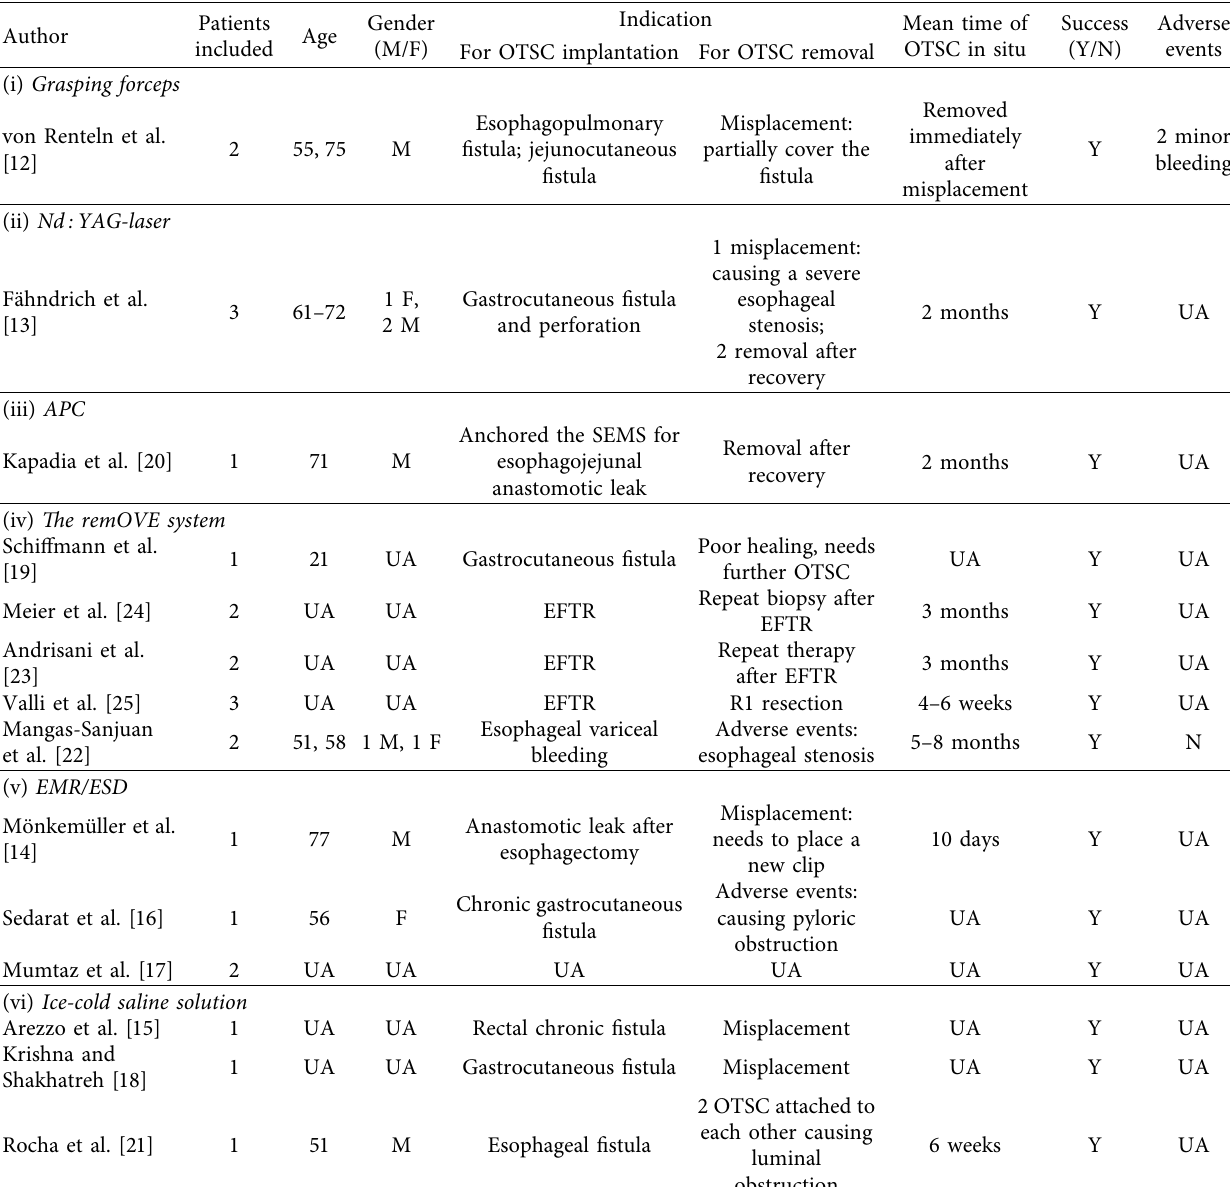
Table 2: Characteristics of the included case